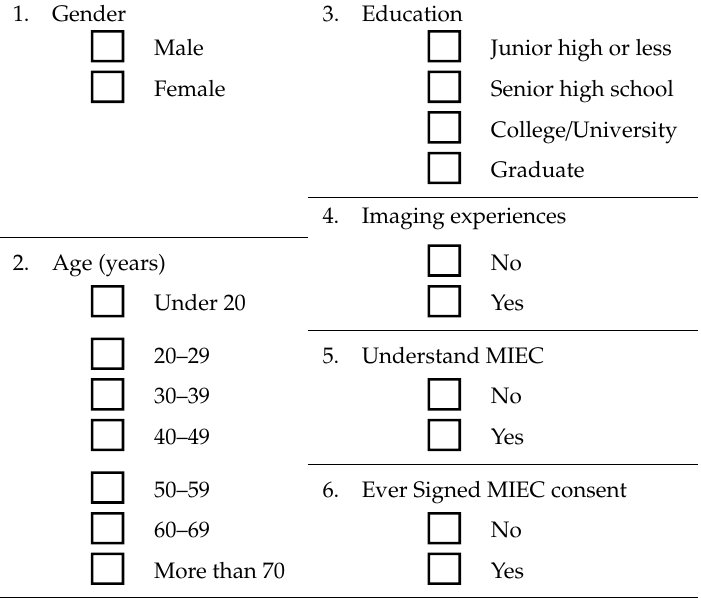
Table A1. Questionnaires: Demographic Information.